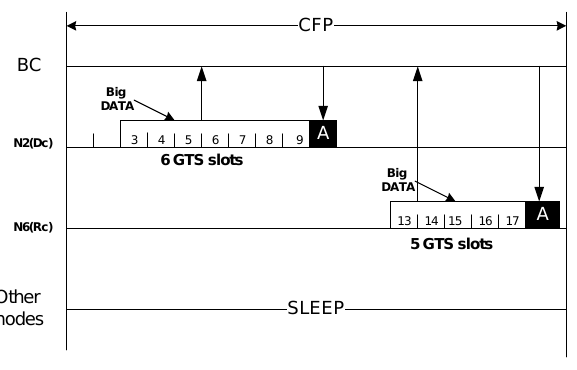
Figure 9. Communication during CFP period.